Question: Give a one-sentence summary of this figure.
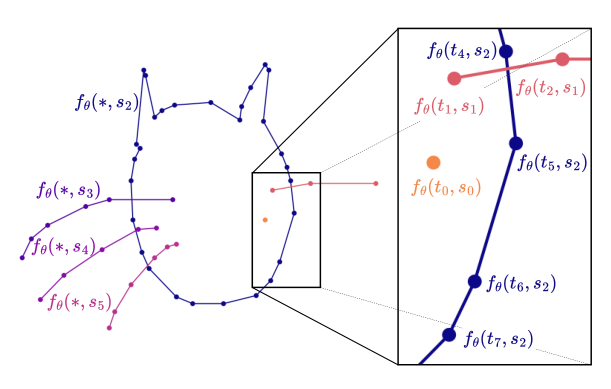
Answer: We model sketch as a function fθ(tj, sk) of J times- tamps and K strokes. Timestamps {ta, . . . , tb} where tj ∈[0, 1) correspond to way-points for a specific stroke sk. Finally, fθ with learned weights θ can be sampled with arbitrary number of strokes as tj ∈{0, 1